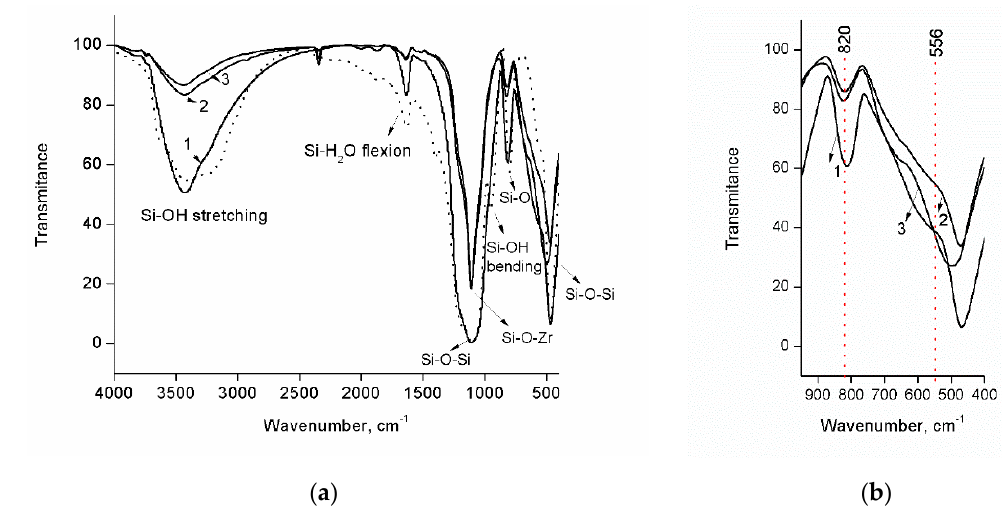
8 of 16 Figure 6 shows the SEM micrograph and EDS analysis for SiO 2 @ZrO 2 0.06M–CaO. The EDS spectrum for the core–shell displayed 3.1 wt% Ca for SiO 2 @ZrO 2 0.06M–CaO and 5.3 wt % Ca for SiO 2 @ZrO 2 0.08M–CaO. For the SiO 2 @ZrO 2 0.04M–CaO sample, the wt % Ca was below 1% (not shown). ( a ) ( b ) Figure 6. Scanning electron microscopy (SEM) micrograph and EDS spectrum data for SiO 2 @ZrO 2 0.06M–CaO at 700 °C: ( a ) SEM image; ( b ) EDS spectrum. 3.4. FTIR Analysis The FTIR technique allows the identification of the chemical bond formation of Si-O-Zr in the core–shell, as well as the Ca-O bond interaction. Figure 7a shows the silanol Si-OH bond in SiO 2 spheres at around 500 cm − 1 and the asymmetric stretching vibration for Si-O-Si at 1100 cm − 1 for SiO 2 spheres [49]. The transmittance bands at 948 cm − 1 and 800 cm − 1 are associated with Si-OH bending vibration and Si-O bending vibrations, respectively. The band around 1637 cm − 1 corresponds to Si- H 2 O flexion and the FTIR band at 3415 cm − 1 to Si-OH stretching mode vibration (Figure 7a). When zirconium was fully incorporated to the SiO 2 spheres, it was expected that the silanol groups of the SiO 2 spheres should be modified [46]. Therefore, the decrease of the Si-O-Si bond intensity in Figure 7 is attributed to their disappearance considering the formation of new Si-O-Zr bonds. The band at 1100 cm − 1 undergoes a shift at 1097 cm − 1 caused by the Si-O-Zr formation, and the degree of the band shift depends on the number of Si-O-Zr bonds, in line with the increment in zirconium precursor concentration [46]. Therefore, because of the surface cover by ZrO 2 , it is also expected that there